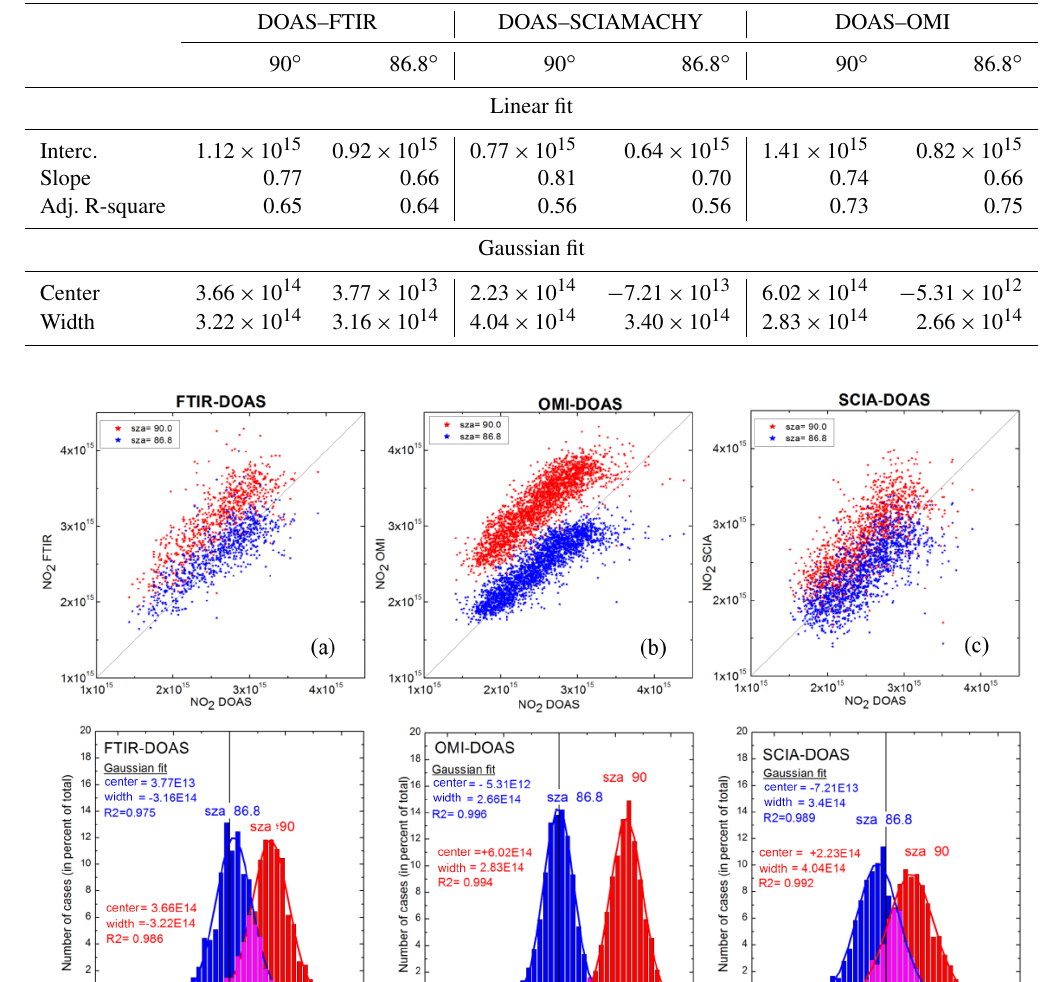
Table 2. Results of the linear fit of DOAS vs. FTIR, OMI and SCIAMACHY NO 2 VCD for SZA = 90 ◦ and ESZA = 86.8 ◦ .